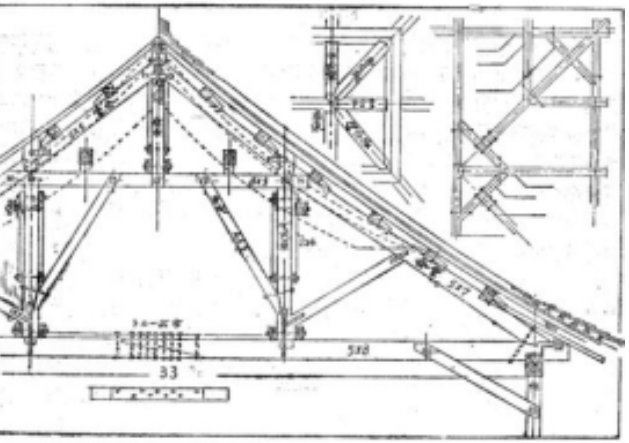
Figure 13. Japanese–Western Hybrid Roof Structure Introduced in Improved Japanese House Structure , 1919 [20].